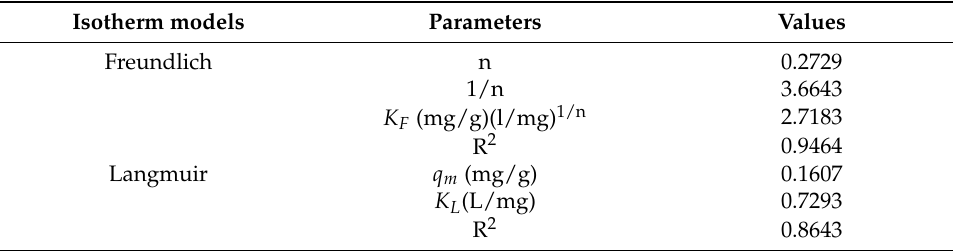
Table 1. Isotherm constants for boron adsorption onto nano-magnetite.